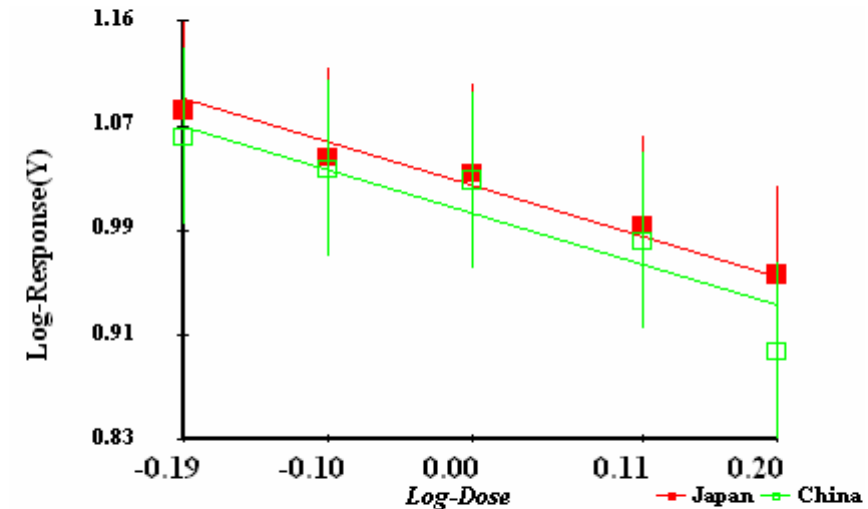
Figure 7: Slope function and parallelism of the hemorrhagic neutralization of Jiangzhe Agkistrodon halys venom by Agkistrodon halys (Japan) and Jiangzhe Agkistrodon halys (China)